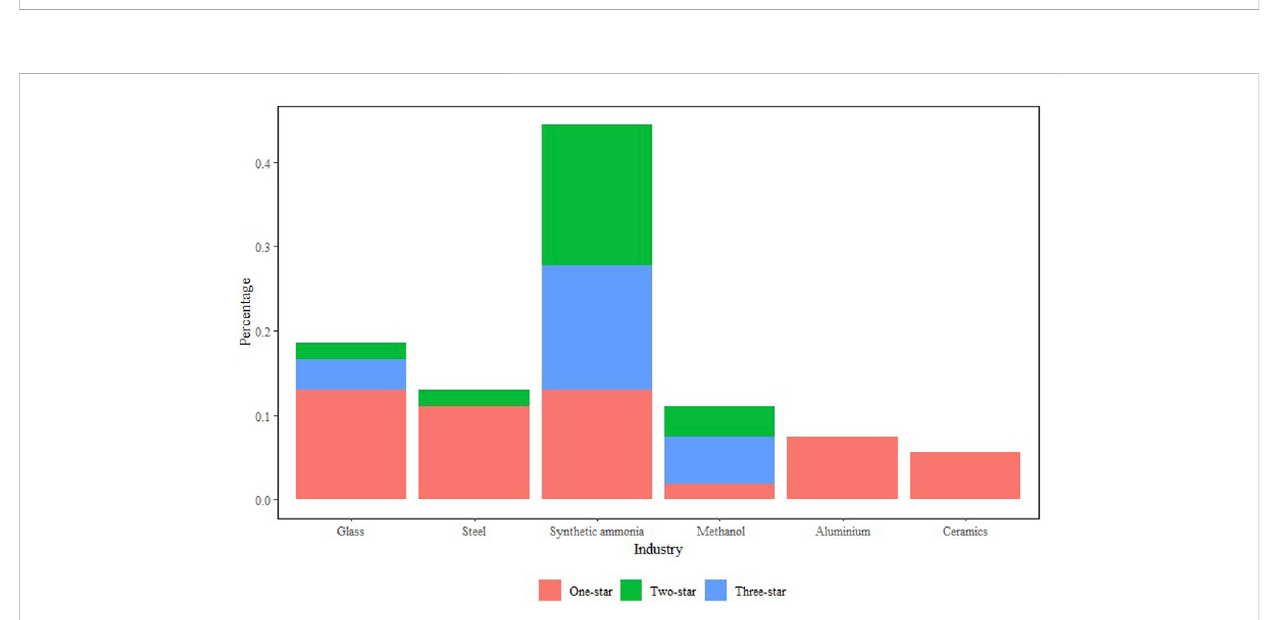
FIGURE 10 Percentage of natural gas customers by the value level and